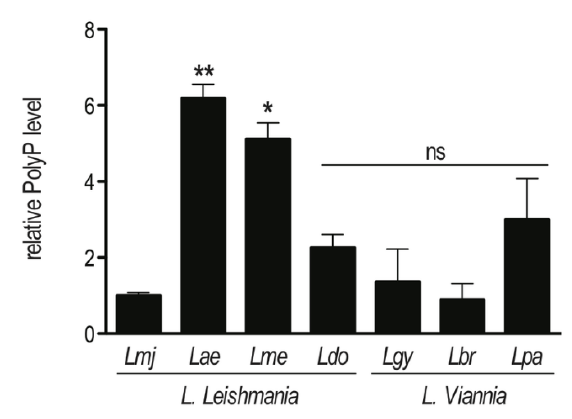
FIGURE 1: High variability of polyP abundance in different Leishmania species. Parasites were grown in complete Schneider’s medium. PolyP was extracted from 2 x 10 7 logarithmic phase (day 3 post dilution) promastigotes, digested with the polyphosphatase Ppx1, and released P i was quantified colorimetrically. Results of a pool of 2 independent experiments were expressed as mean ± SD of polyP level relative to L. major . Statistical significance